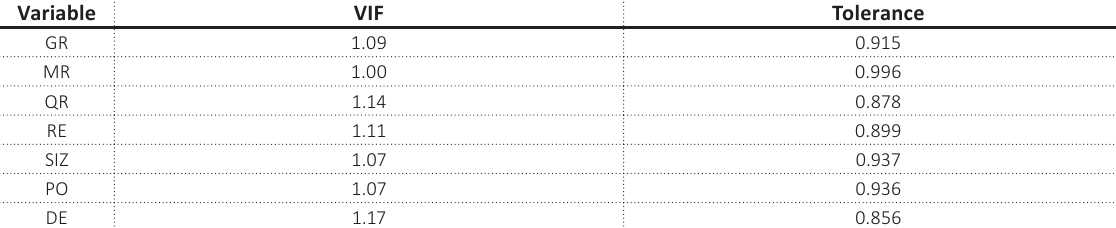
Table 3. Multicollinearity